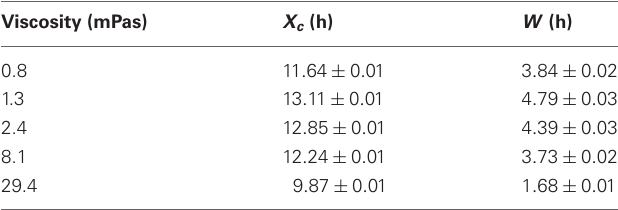
Table 2 | Parameters of prodigiosin production